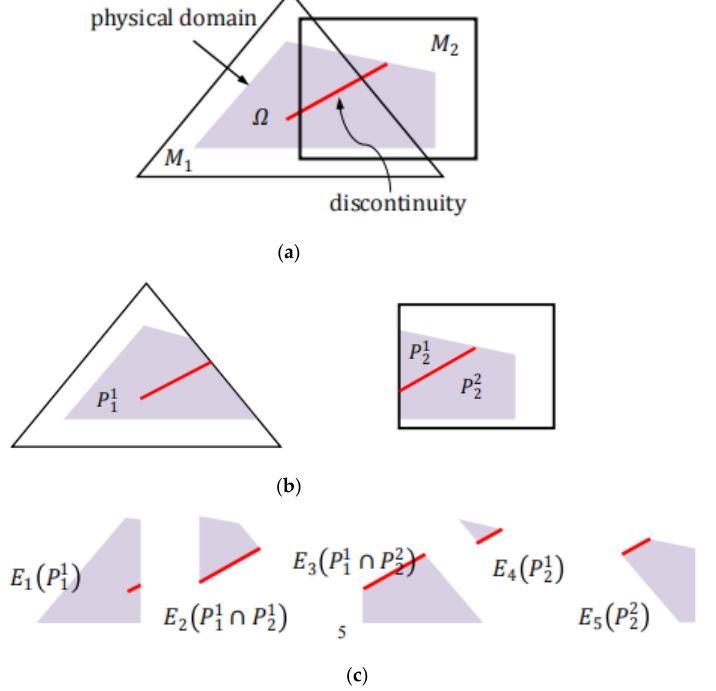
Figure 1. An illustration of the cover system of the NMM: ( a ) MCs and physical domain; ( b ) PCs; ( c ) MEs.